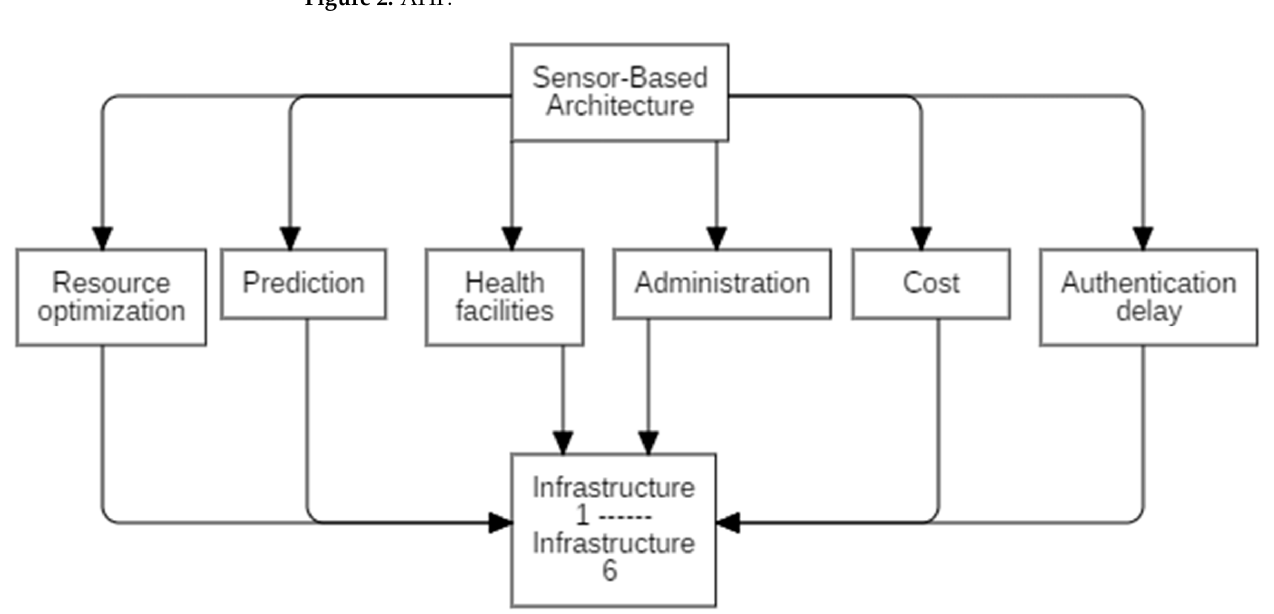
Figure 3. Hierarchical Diagram.